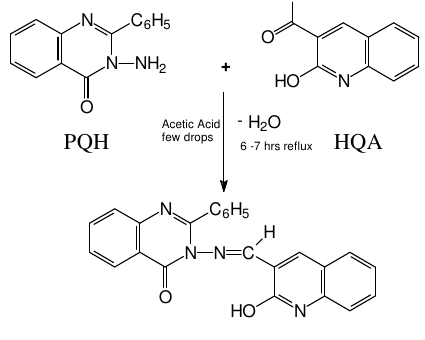
Figure 2 . Synthesis of